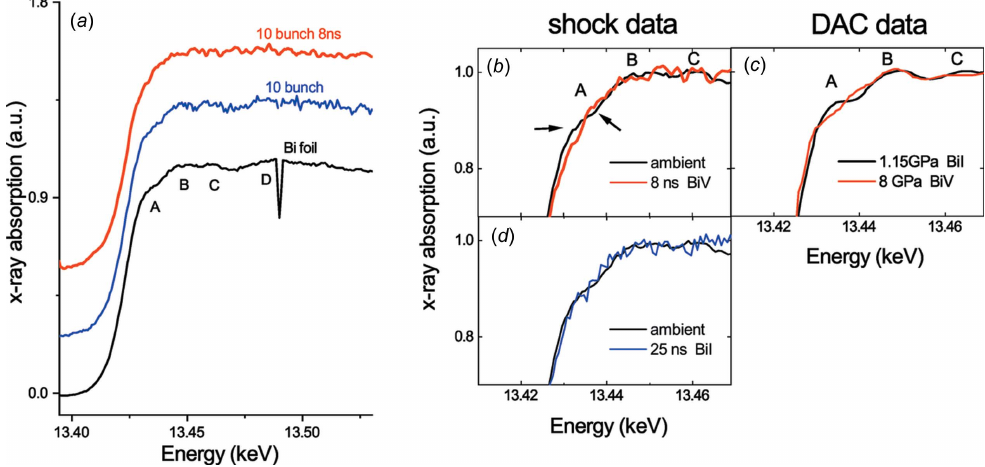
Figure 14 ( a ) Bi foil reference spectrum (black), Bi target spectrum obtained summing 10 X-ray pulses (blue) and shocked Bi target at 8 ns of laser delay (average of 10 X-ray pulses, red). ( b ) Observation of the Bi I to Bi V transition at 8 ns and ( c ) comparison with literature static data. ( d ) Recovery of the Bi I phase at 25 ns (blue spectrum, average of 5 X-ray pulses).